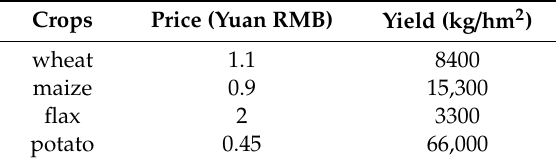
Table 4. The price and yield of di ff erent